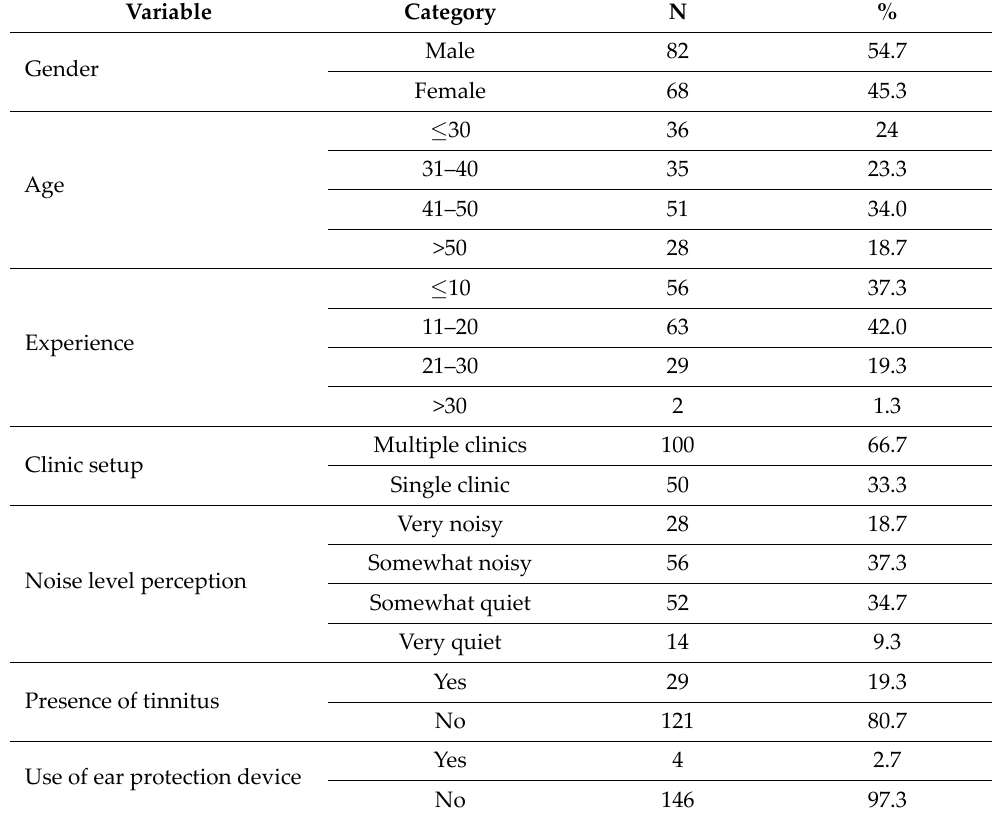
Table 1. Baseline